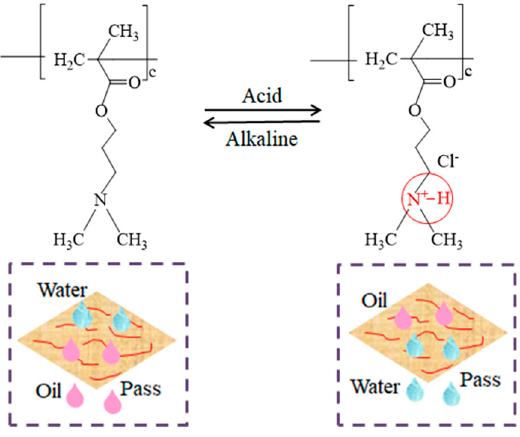
Figure 16. Mechanism of temperature response.